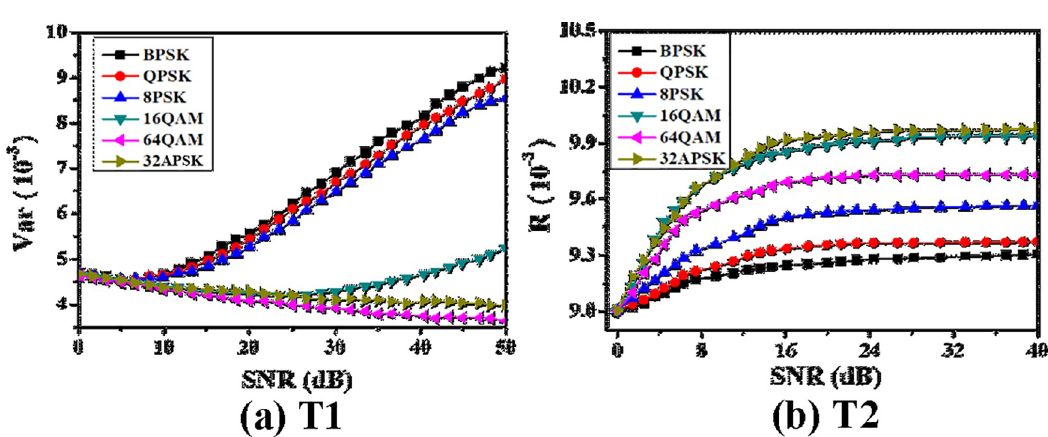
Fig 4. Variation curves of characteristic parameters of different modulation signals with SNR.